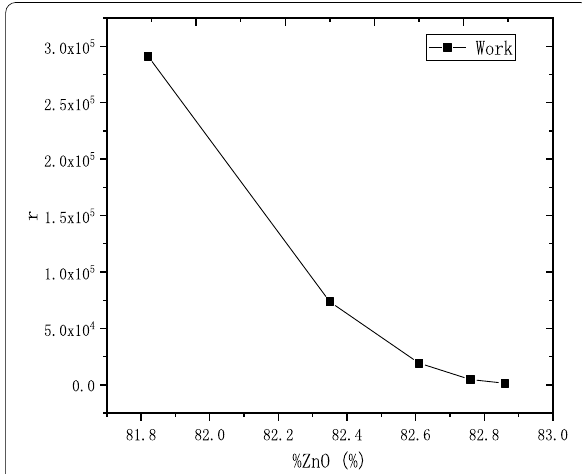
Fig. 11 The r with the percentage of ZnO cycles diagram at the working